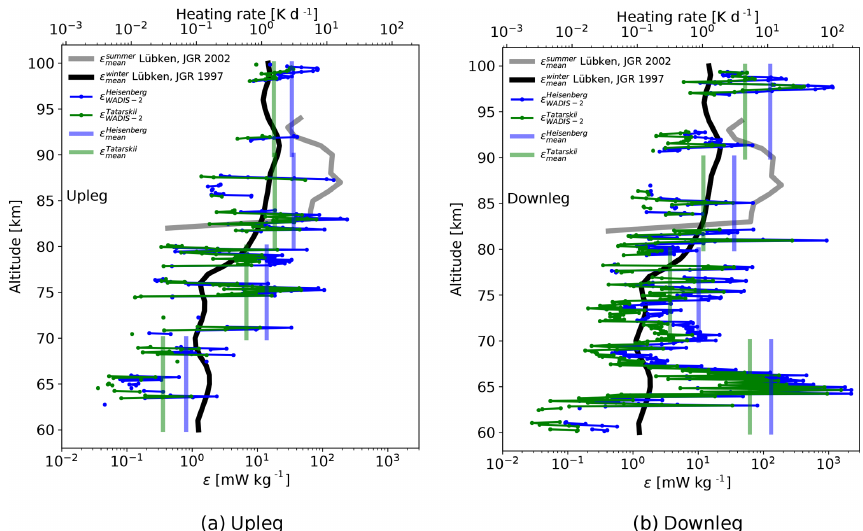
Figure 12. In situ turbulence measurements by the WADIS-2 rocket launched on 1 March 2015 at 01:44:00UTC. Blue and green represent turbulence energy dissipation rates, ε , derived using the spectral models of Heisenberg (1948) and Tatarskii (1971), respectively. Vertical lines show mean ε values over the 10km height bins. Bold black and gray profiles show turbulence climatologies for winter and summer, respectively.